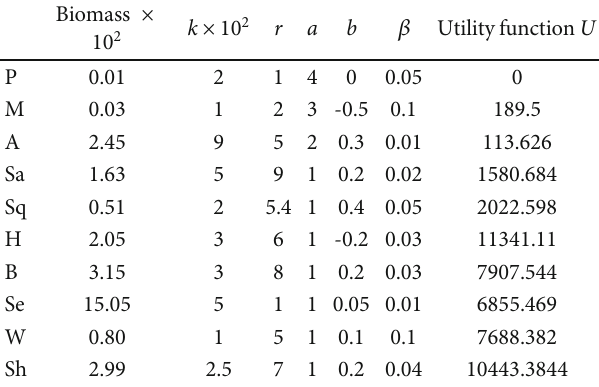
Table 2: Values of parameters and utility function of each